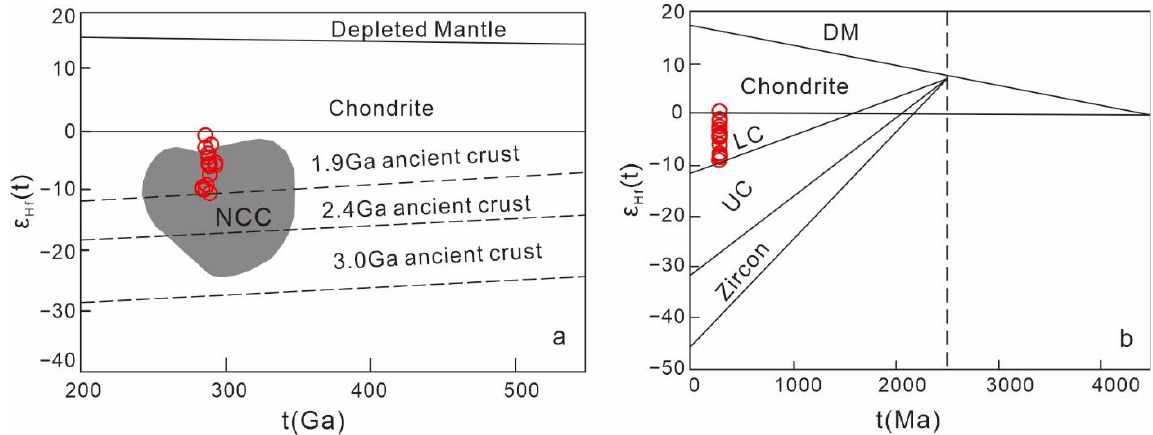
Figure 5. ε Hf (t)-t diagrams of the Zhaojinggou monzogranite. ( a ) Hf isotope contrast with NCC; the gray field indicates Carboniferous – Permian intrusive rocks on the northern margin of the NCC (after [29]). ( b ) Hf isotope evolution.